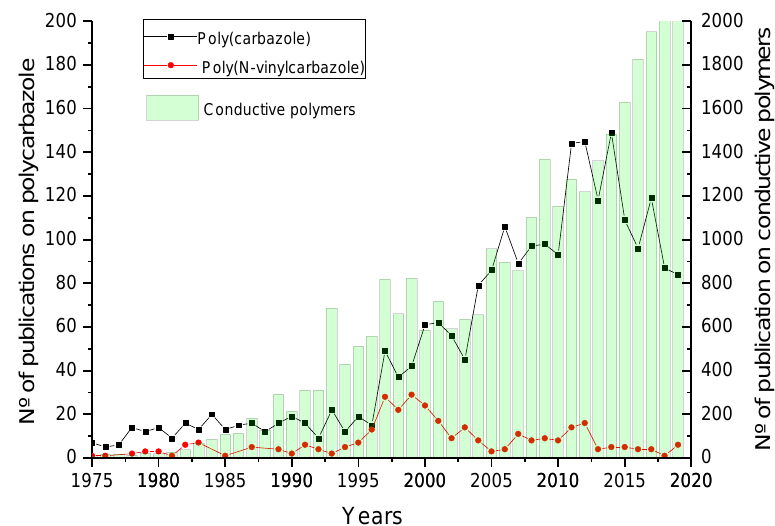
Figure 3. The evolution on the number of publications of conductive polymers (green), polycarbazole derivatives (black) and poly(N-vinylcarbazole) (red) (Source: Scopus).